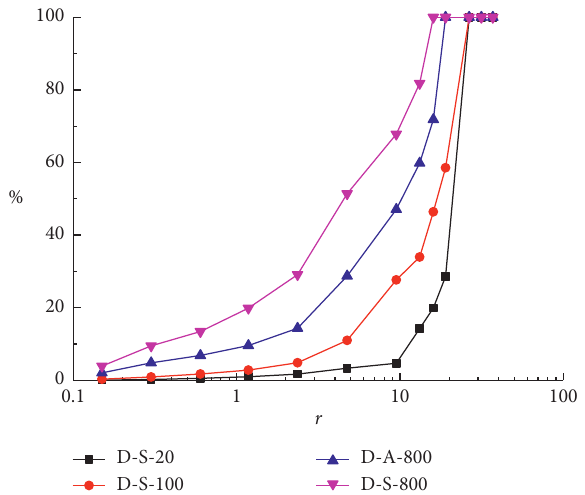
Figure 10: Typical grading curve of argillaceous sandstone